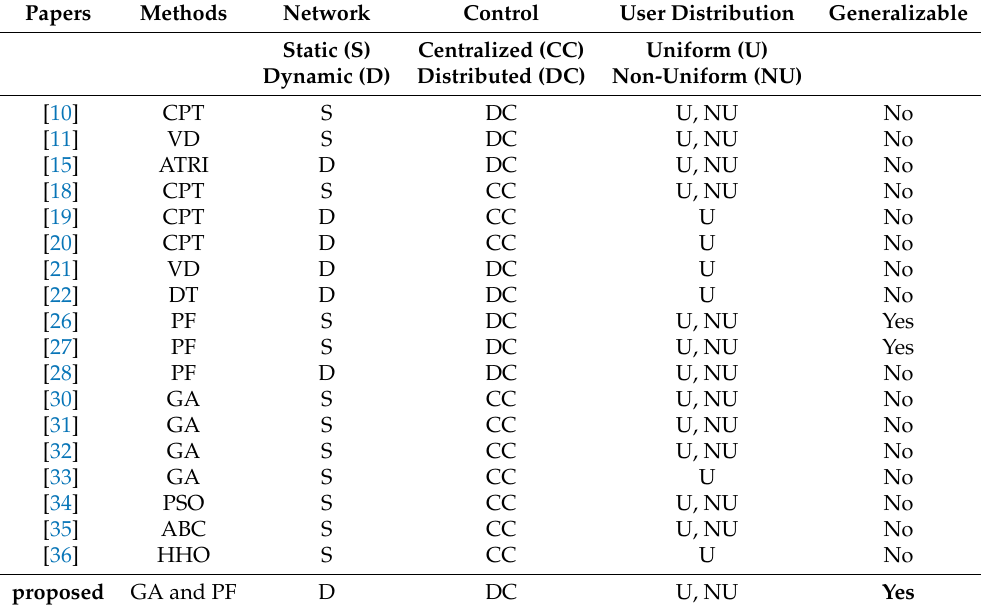
Table 1. Comparison of wireless network deployment methods.